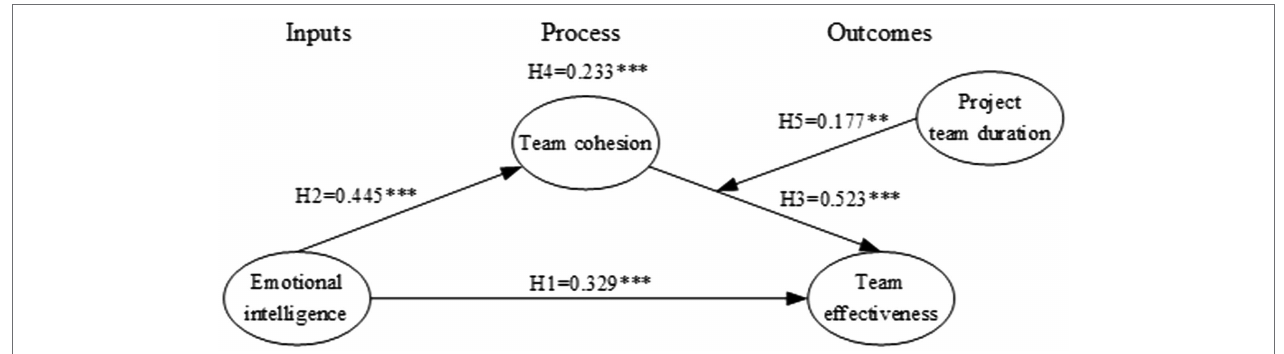
FIGURE 3 | Test results of the final model. ** p < 0.01; *** p <